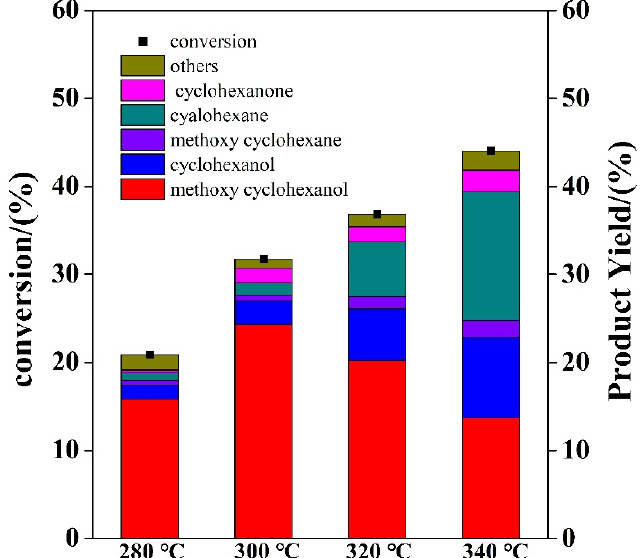
Figure 7. Effect of temperature on guaiacol conversion and product distribution over 0.85 Au/Ni-TiO 3 . Reaction conditions: catalyst 0.2 g, guaiacol 1.30 g, decane 25 mL, P (H 2 ) = 3 MPa, 300 °C, 700 rpm.